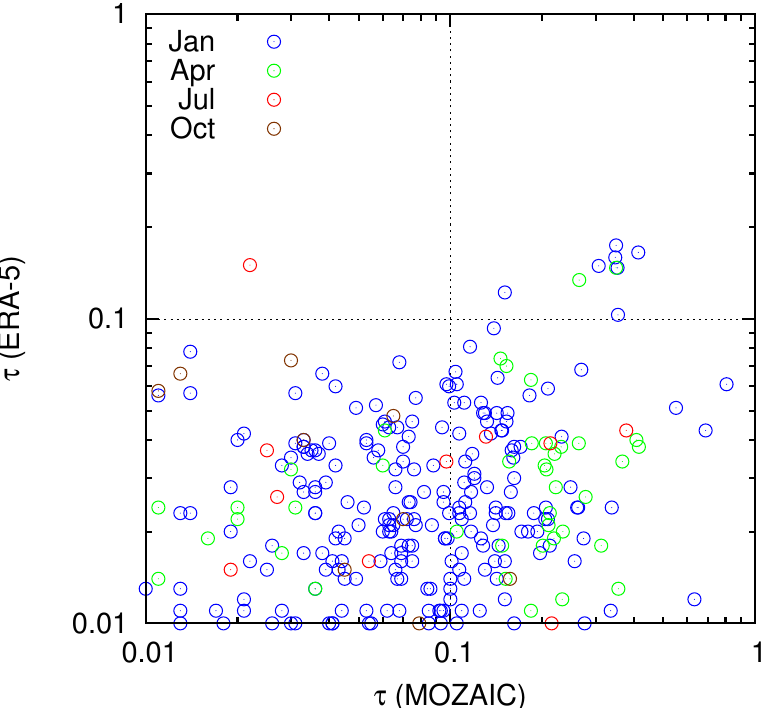
Figure 4. Scatterplot of optical thickness values for persistent contrails that occur in both MOZAIC ( x -axis) and ERA-5 ( y -axis). Colour coding as before for the four